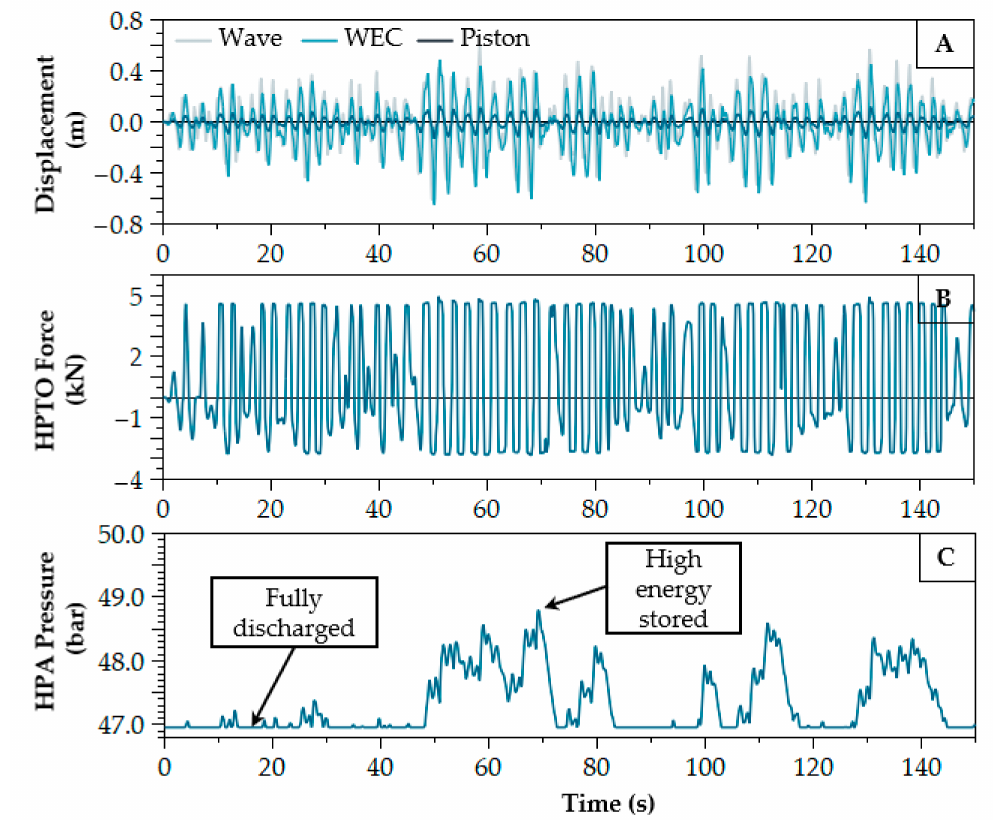
Figure 6. Performance of WEC with HPTO unit in sea state A, ( A ) Displacement of Wave, WEC and hydraulic cylinder piston, ( B ) HPTO force applied to WEC device, and ( C ) Pressure of high-pressure